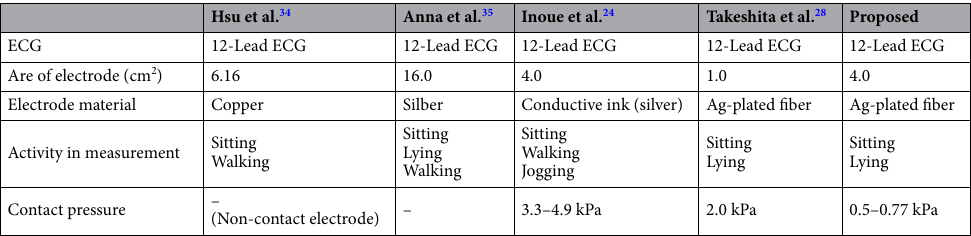
Table 1. The specification comparisons between different dry electrodes for 12-lead ECG